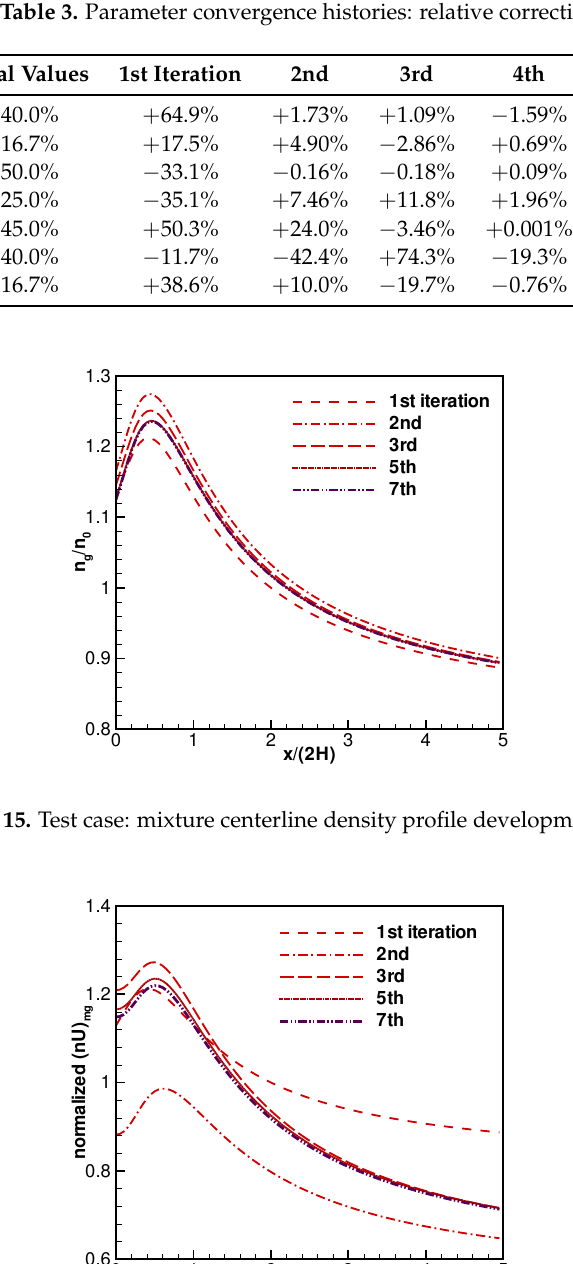
Figure 16. Test case: mixture centerline number flux nU / ( n 0